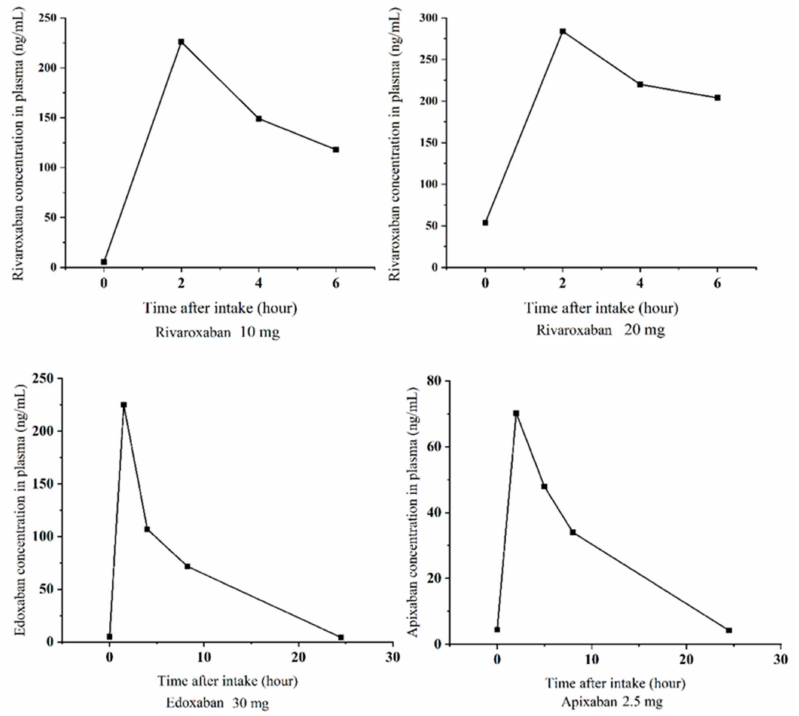
Figure 5. Brief concentrate-time curve of patients and subjects treated with rivaroxaban, edoxaban, and